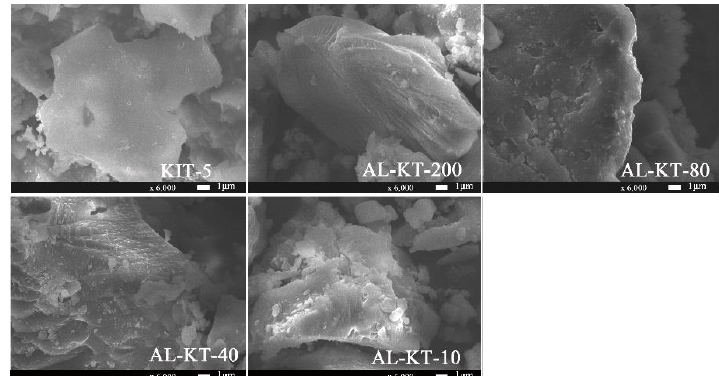
Figure 4. Scanning electron microscopy (SEM) images of the Al-KT-X and KIT-5 supports.